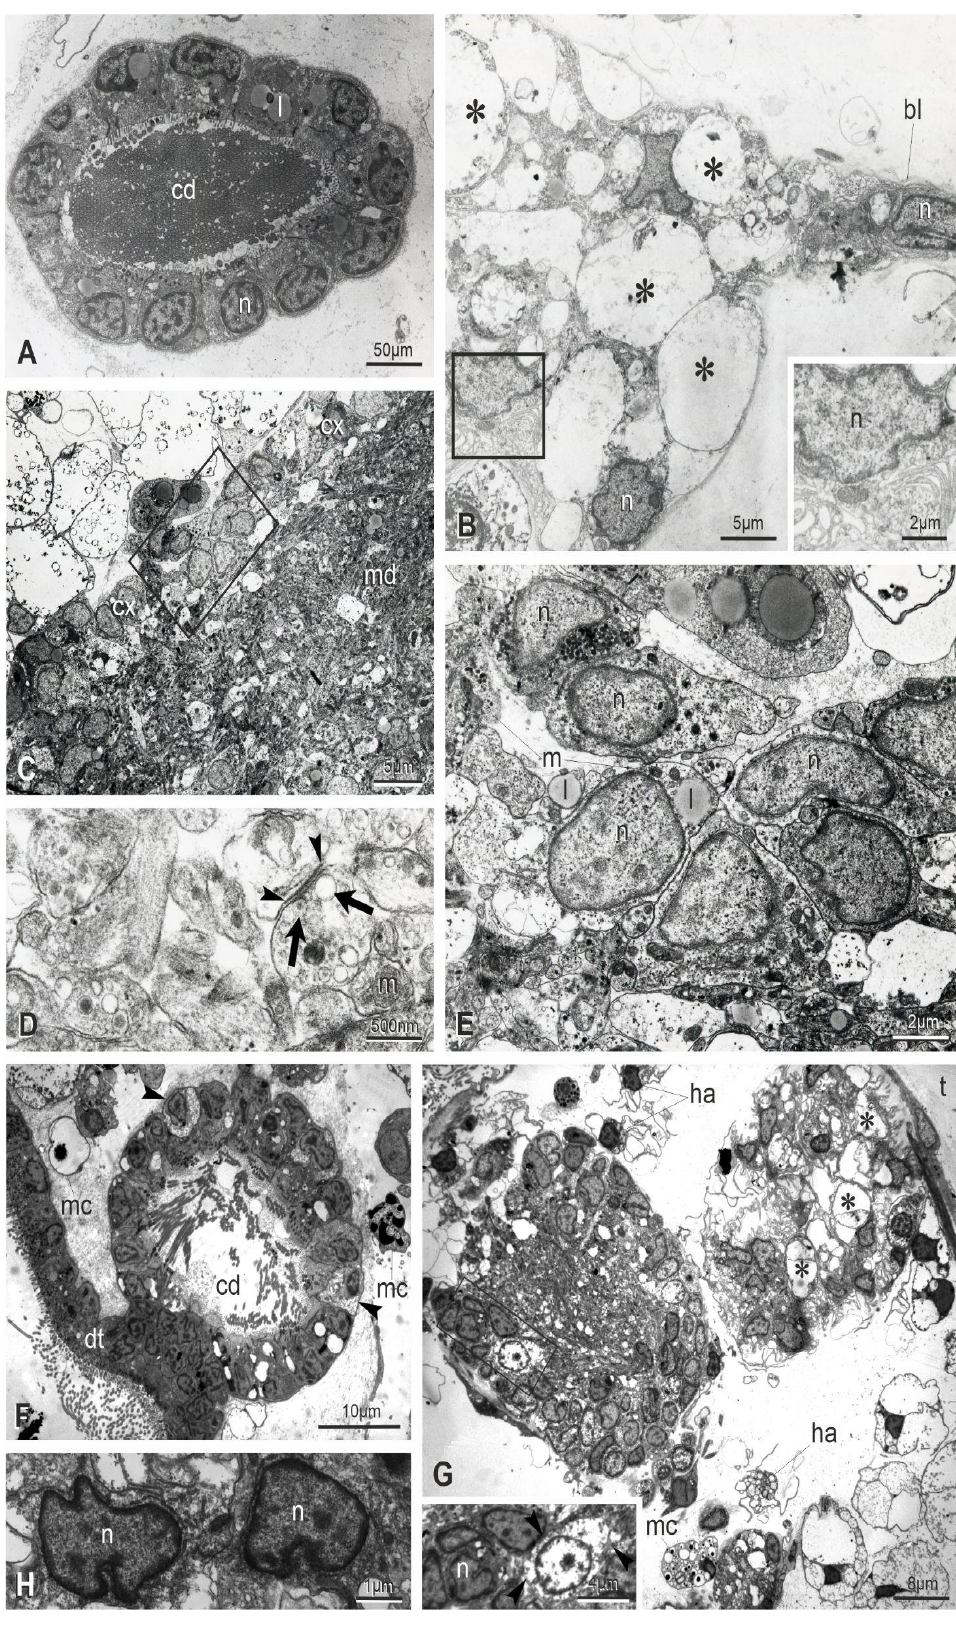
Figure 3. Ultrastructure of the neural complex in filter-feeding zooid (mid-cycle) ( A – E ) and in a regressing zooid at sub-stage 11 1 ( F – H ). TEM. ( A ) Thin sections revealing that the ciliated duct (cd) of the neural gland is highly ciliated. l: lipid droplet; n: nucleus in a ciliated duct cell. ( B ) Section